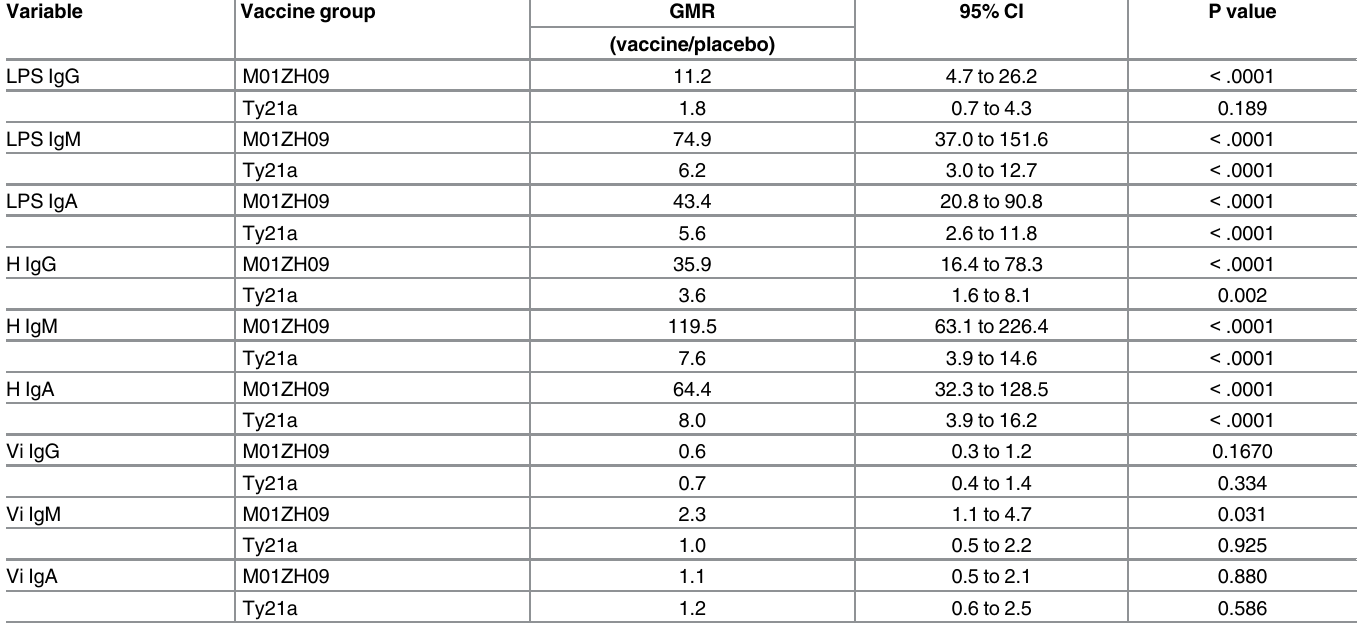
Table 5. Analysis of covariance comparisons for increase in ASC titres against LPS, flagellin (H) and Vi between prevaccination (Day -28) and Day -21, between each active vaccine group (1. M01ZH09 and 2. Ty21a) and placebo. Analyses were performed with the dependent variable log(change from baseline) with adjustment for log(pre-vaccination) values. GMR, geometric mean ratio compared to placebo.